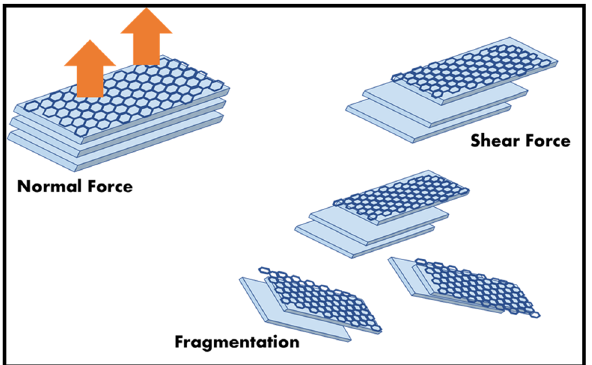
Figure 12: Schematic representation of the two kinds of mechanical routes for exfoliating graphite into graphene fl akes and the auxiliary route for